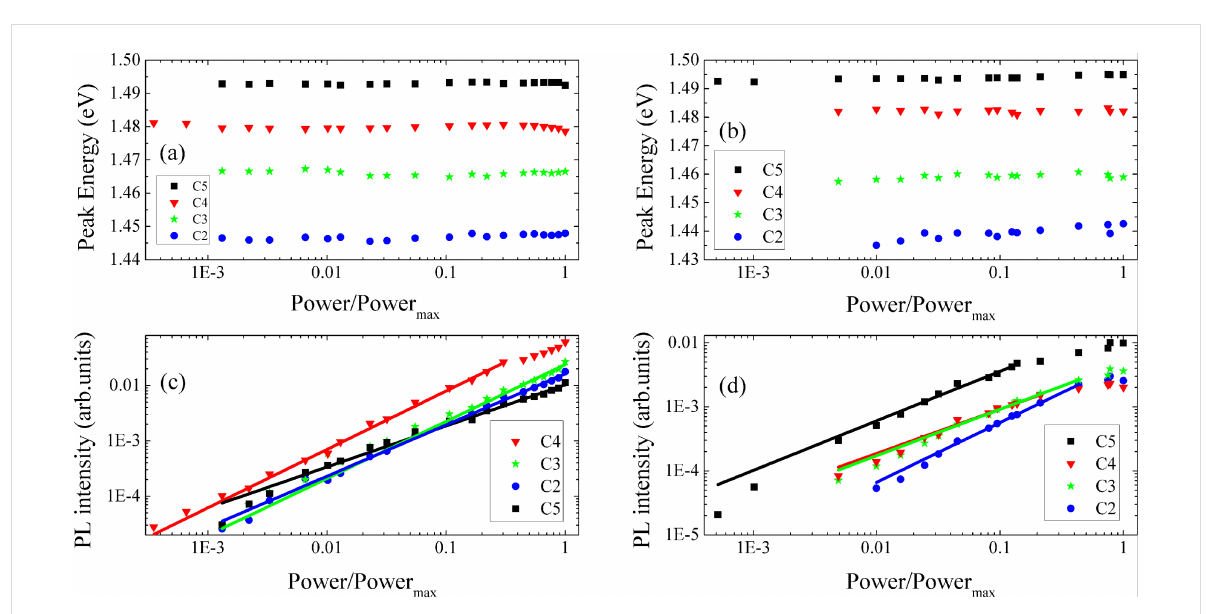
Figure 6: Dependence on the excitation power of the peak energy for (a) sample A and (b) sample B, and of the PL intensity for (c) sample A and (d) sample B. The lines in (c) and (d) are the fits of Equation 4 to the experimental points.